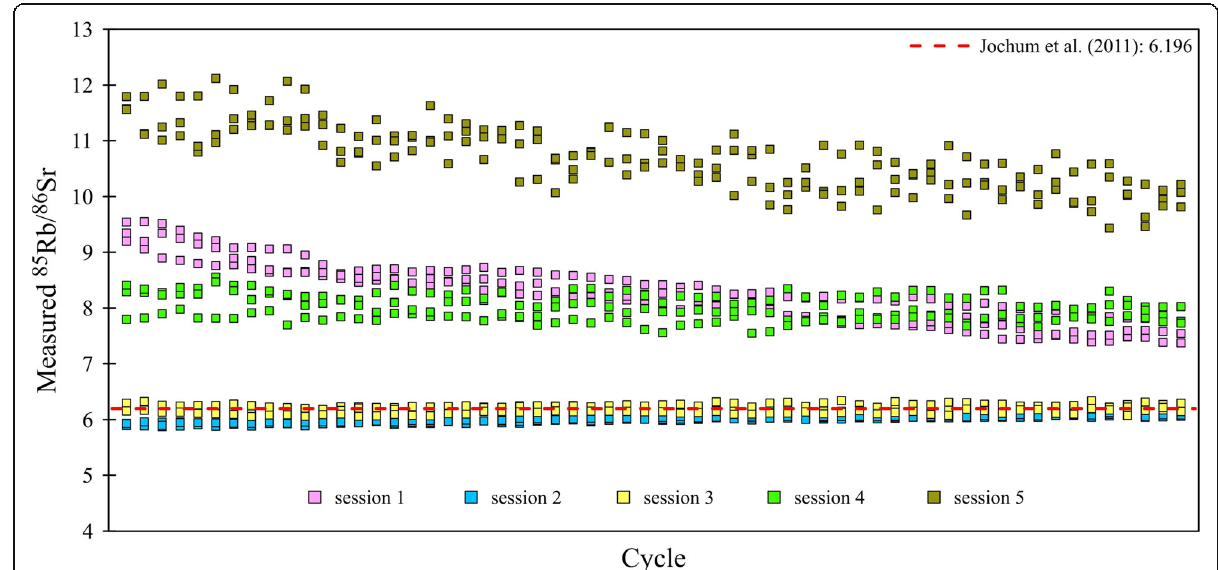
Fig. 3 Variations of 85 Rb/ 86 Sr ratios measured for SRM 610 during LA-MC-ICPMS sessions. The dashed line represents the recommended 85 Rb/ 86 Sr ratio (= 6.196; Jochum et al.